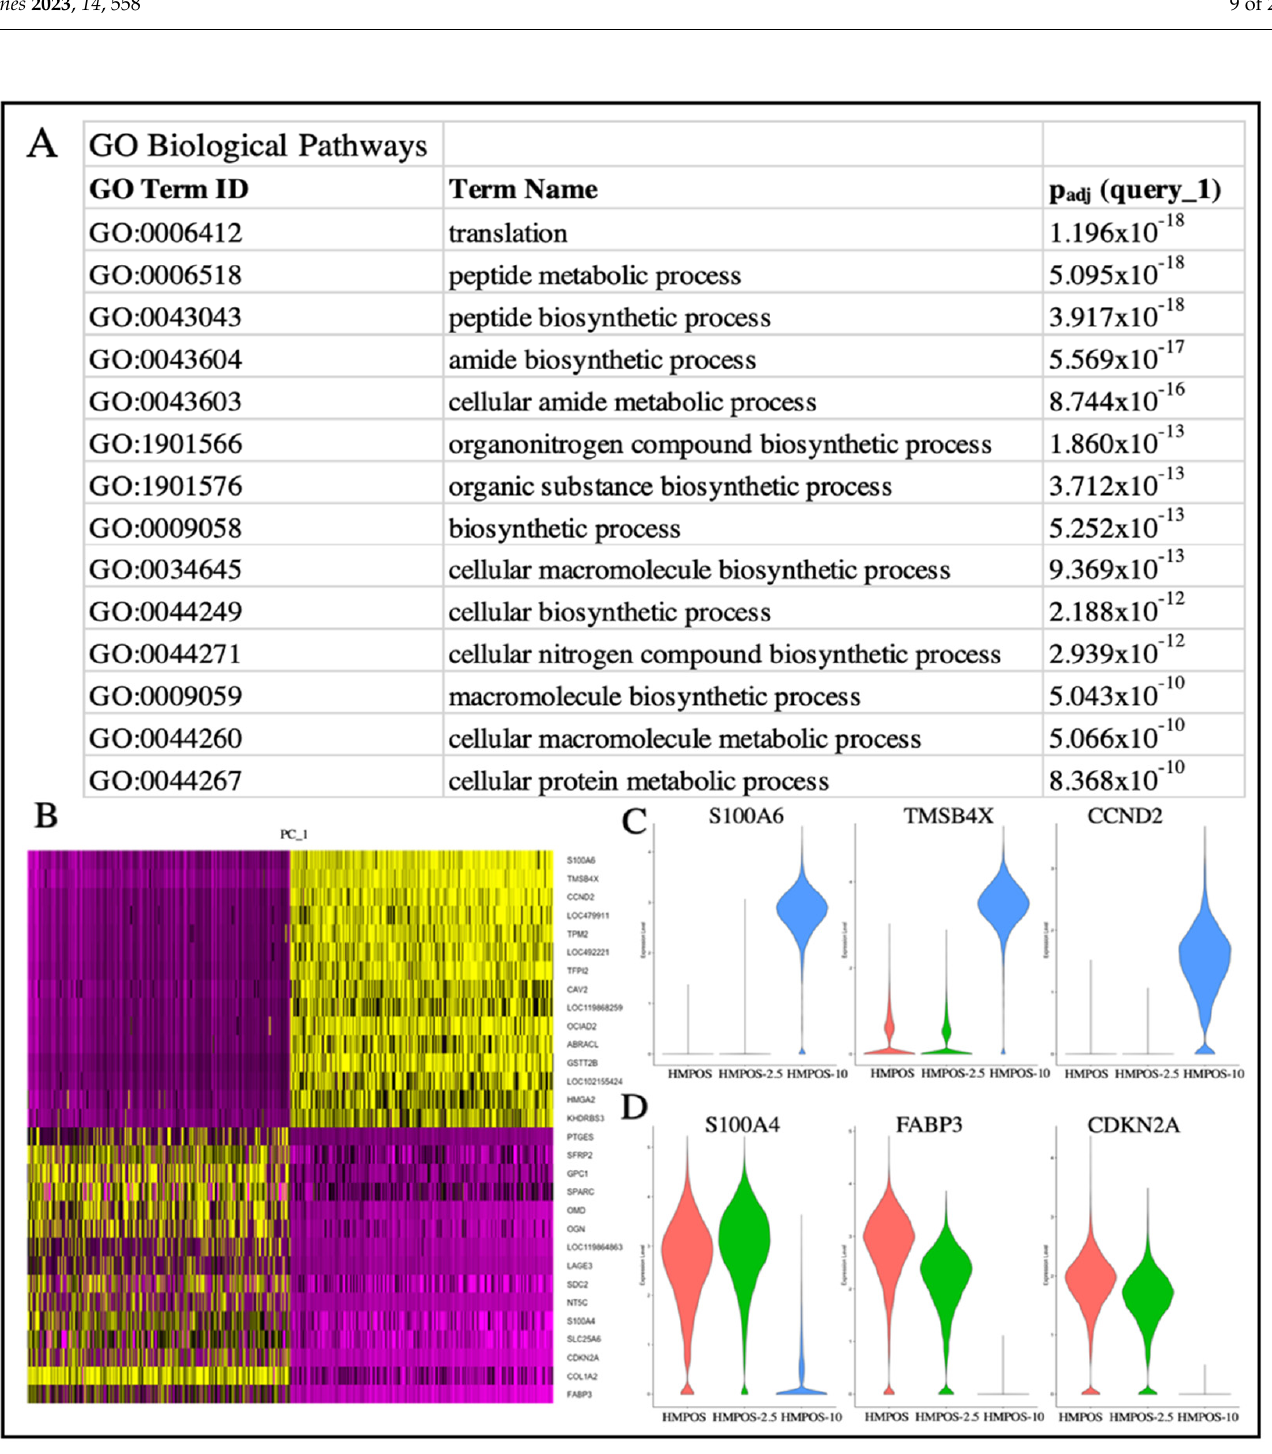
Figure 4. ( A ) gProfiler analysis of the biological pathways related to the upregulated genes of the HMPOS cell line in comparison with the 2.5 and HMPOS-10 cell lines. ( B ) DimHeatmap showing the primary sources of heterogeneity. ( C ) Violin plot of genes from PC_1, i.e., the most highly differentially expressed genes that coordinate with the HMPOS-10 cell line. ( D ) Violin plot of genes from PC_1, i.e., the most highly differentially expressed genes that coordinate with the HMPOS-2.5 and HMPOS cell lines.